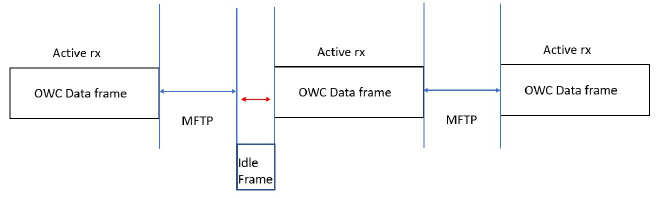
Figure 1. Mitigation of interframe